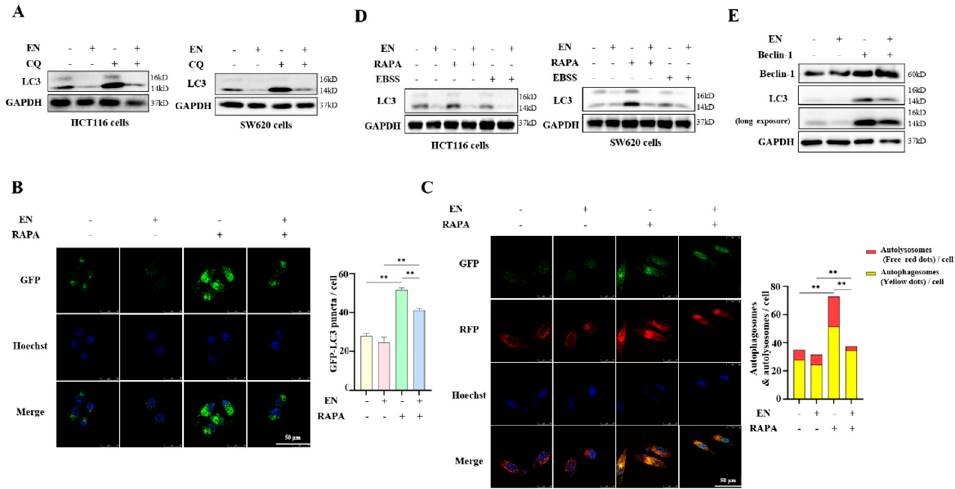
Figure 3. EN inhibits autophagy in colon cancer cells. ( A ) CQ (10 μ M) and EN (16 μ M) were used to treat HCT116 or SW620 cells for 12 h. The cells were then harvested, and Western blotting analysis was performed. ( B ) HeLa cells with stable expression of GFP − LC3 were seeded in the chambers and pretreated with rapamycin (200 nM) for 2 h. After that, cells continued to be treated with EN (16 µ M) for 12 h. A confocal microscope was used to photograph the formation of GFP − LC3 puncta.